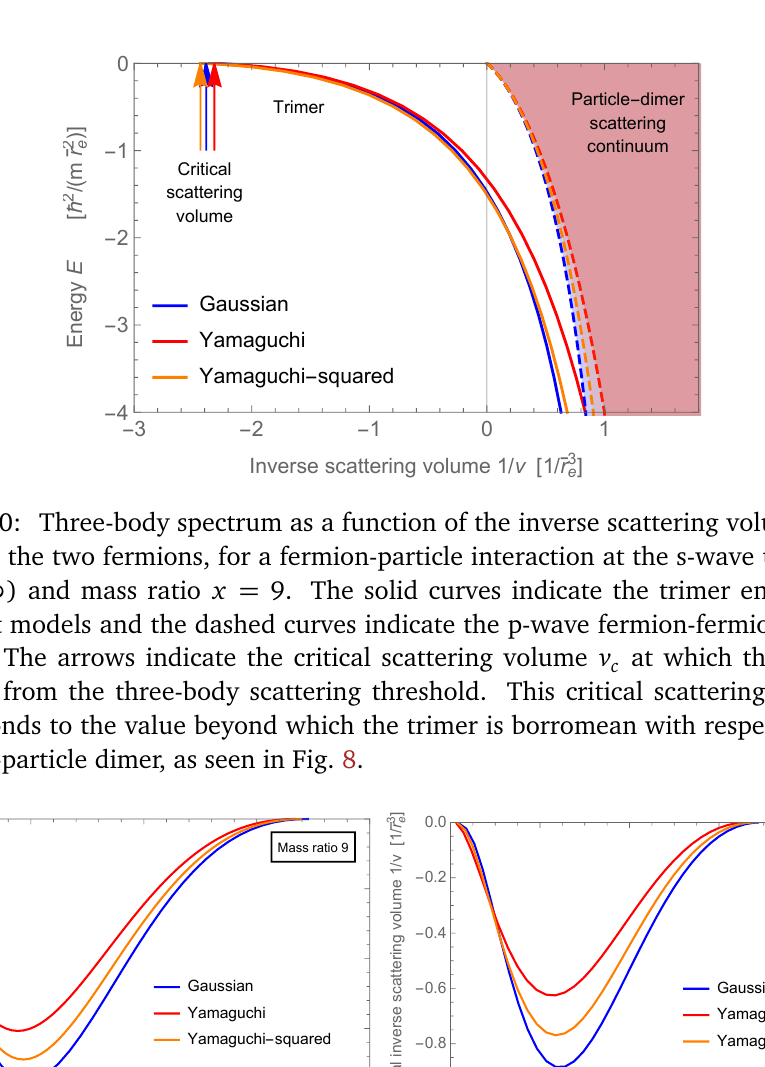
, as a function of the width c